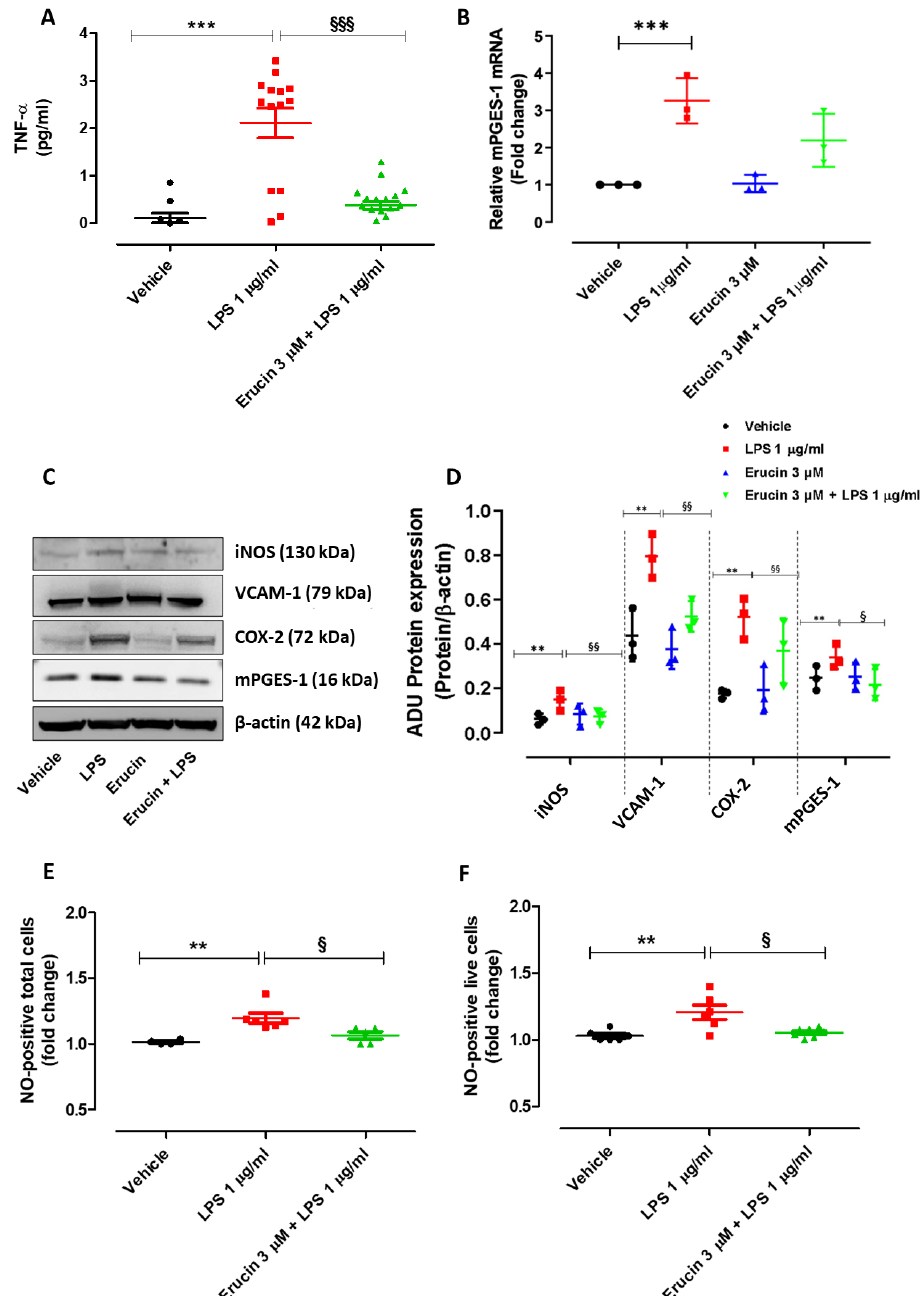
Figure 6. Preventive effects of erucin against inflammatory markers upregulation. TNF- α production ( A ) in HUVECs treated with erucin (3 µ M) or vehicle (0.03% DMSO) for 1 h, and then with LPS 1 µ g/mL co-incubated for 24 h. Graph shows the levels of TNF- α (pg/mL) measured in cell super- natants. Results are shown as mean ± SEM. ( B ) mPGES-1 gene expression evaluated by RT-PCR. ( C ) Western blot analysis of VCAM-1 and inflammatory markers: iNOS, COX-2 and mPGES-1. Each lane contains 50 µ g of total proteins obtained from endothelial cells pre-treated with erucin (3 µ M, 1 h) and then exposed to LPS (1 µ g/mL, 24 h). ( D ) The graph represents the quantification of the optical density of each protein of interest with respect to its β -actin. Results are shown as mean ± SD (n = 33). Graph ( E ) shows the change in NO-positive total cells (live and dead), while ( F ) shows the change in NO-positive live cells treated with erucin (3 µ M) or vehicle (0.03% DMSO) for 1 h, and then with LPS 1 µ g/mL co-incubated for 24 h. Results are shown as mean ± SEM. * indicates significant difference vs. vehicle (** p < 0.01; *** p < 0.001), and § indicates significant difference vs. LPS 1 µ g/mL (§ p <0.05; §§ p < 0.01; §§§ p <